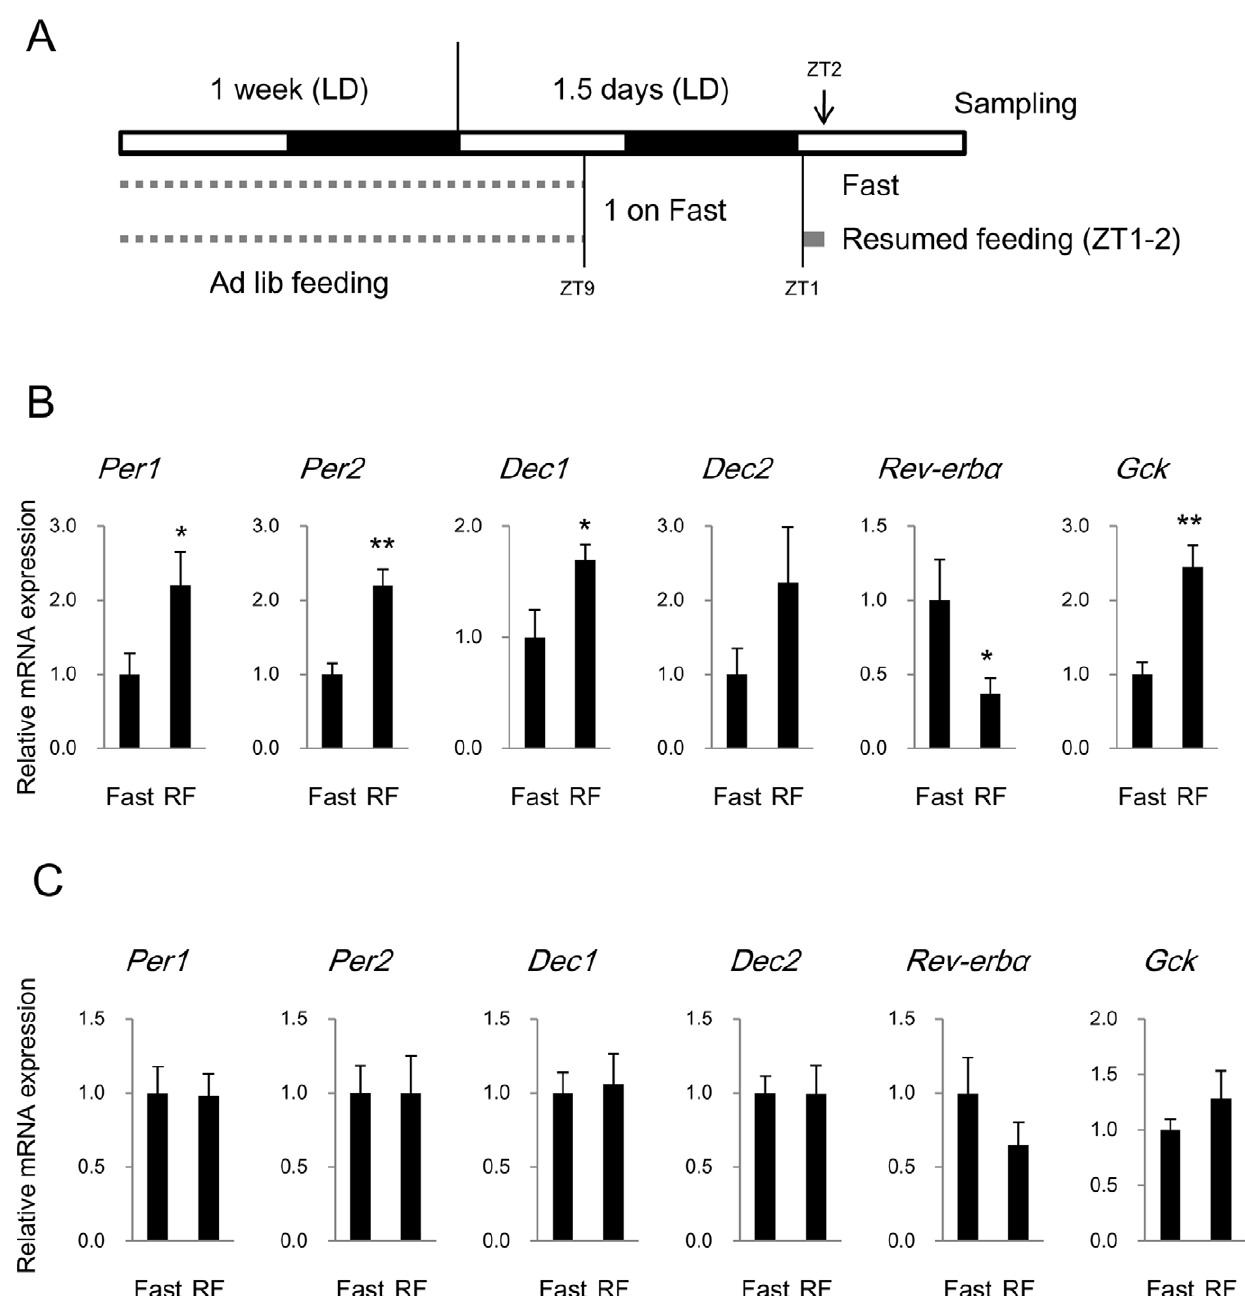
Figure 3. Rapid response in clock gene and Gck expression in liver and lung after resumed feeding. (A) Experimental design. BALB/c mice were fasted overnight and assigned to resumed feeding (RF). Mice in RF group resumed feeding for 1 h and those in Fast group (control) continued to fast. All animals were sampled at ZT2. (B and C) Expression of mRNAs for clock genes and Gck in liver (B) and lung (C) is shown as means 6 SEM relative to control group (n=8, * p , 0.05, ** p , 0.01;